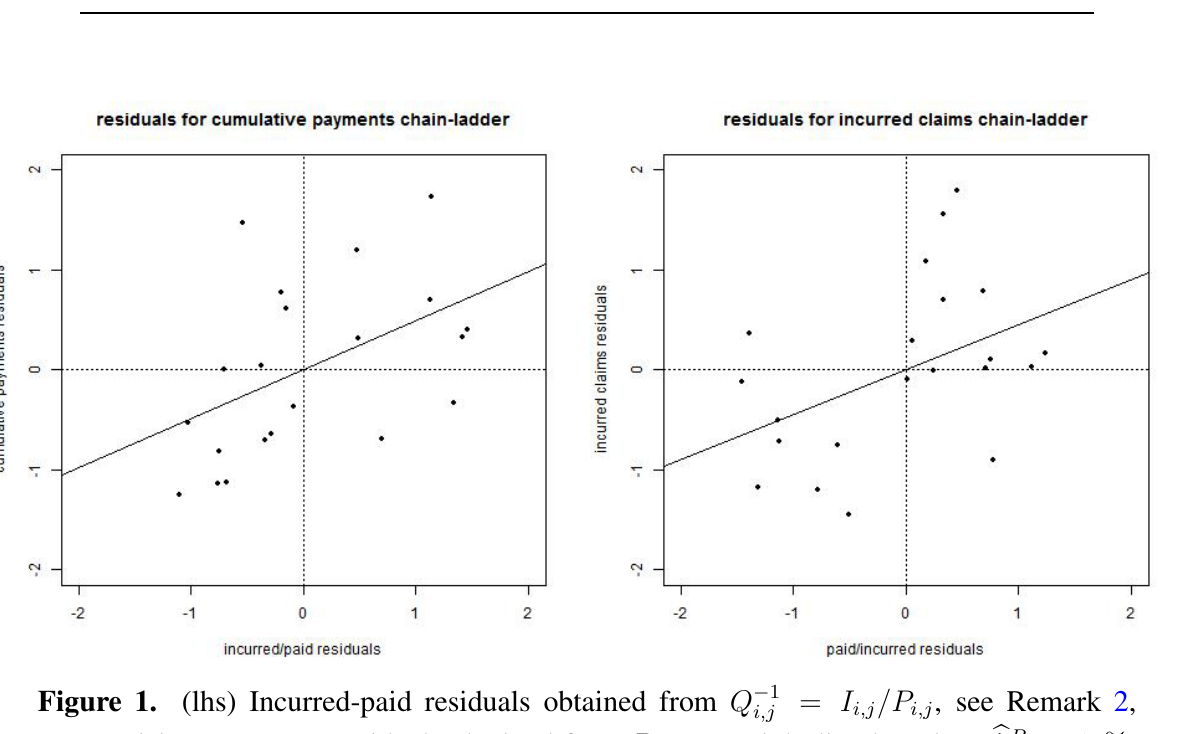
Figure 1. (lhs) Incurred-paid residuals obtained from Q − 1 versus claims payments residuals obtained from P (rhs) paid-incurred residuals obtained from Q obtained from I , straight line has slope (cid:98) λ I = 45% i,j +1